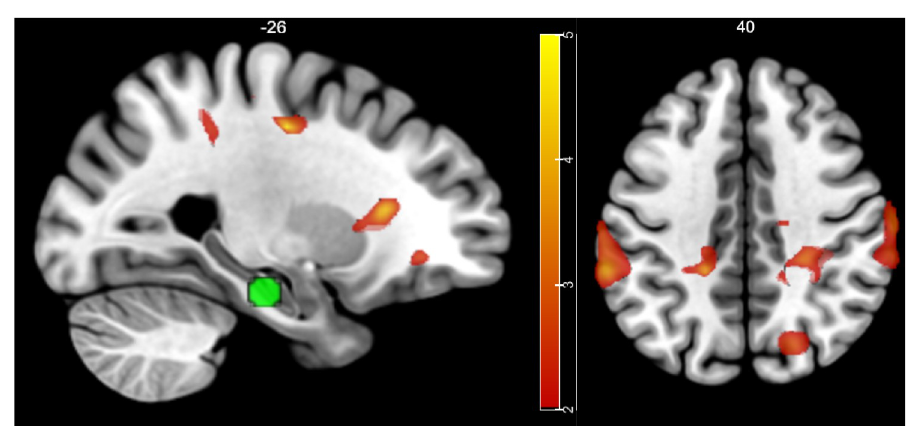
Fig 8. fMRI results: PPI. Color bar indicates t-statistics. (Left) The seed region, the HC (-22, -20, -20), is represented as a green sphere.